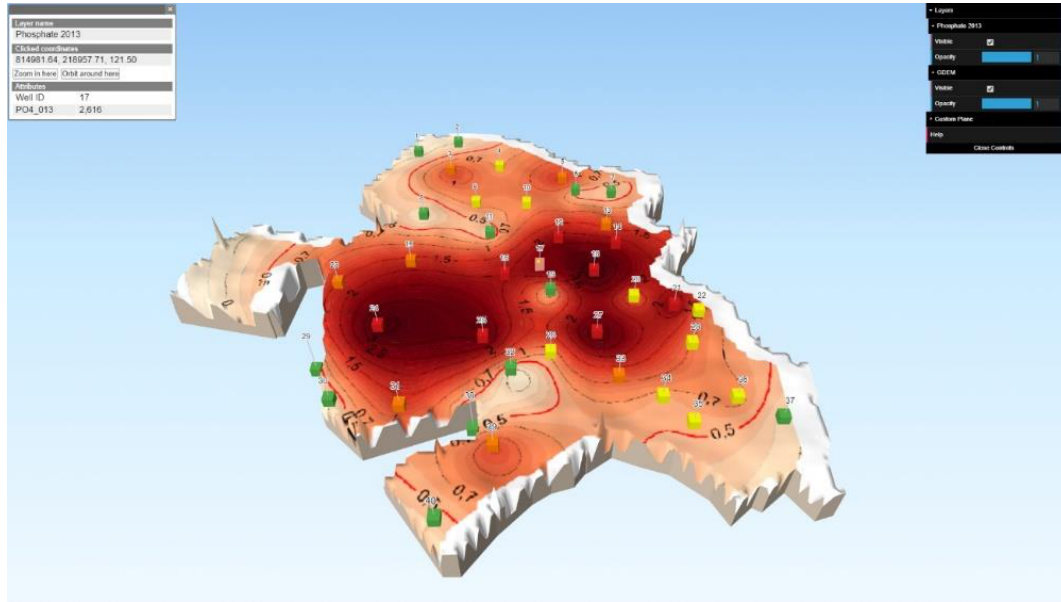
Figure 7. Visualized interface of monitoring wells with description data.